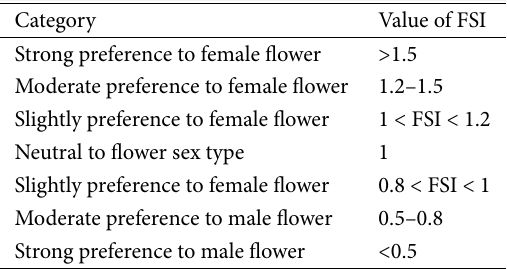
Table 1 Categories of floral visitors based on